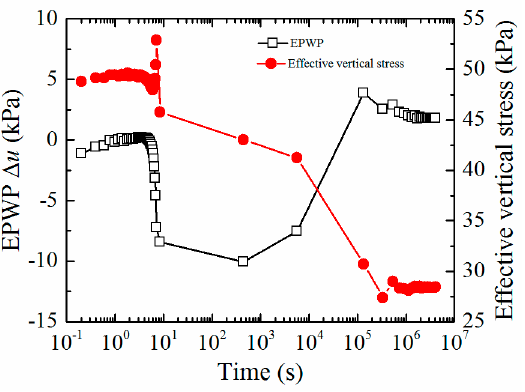
Figure 23. Time histories of the EPWP and effective stress of soil at depth of 9.0 m at z p = 7.8 m.